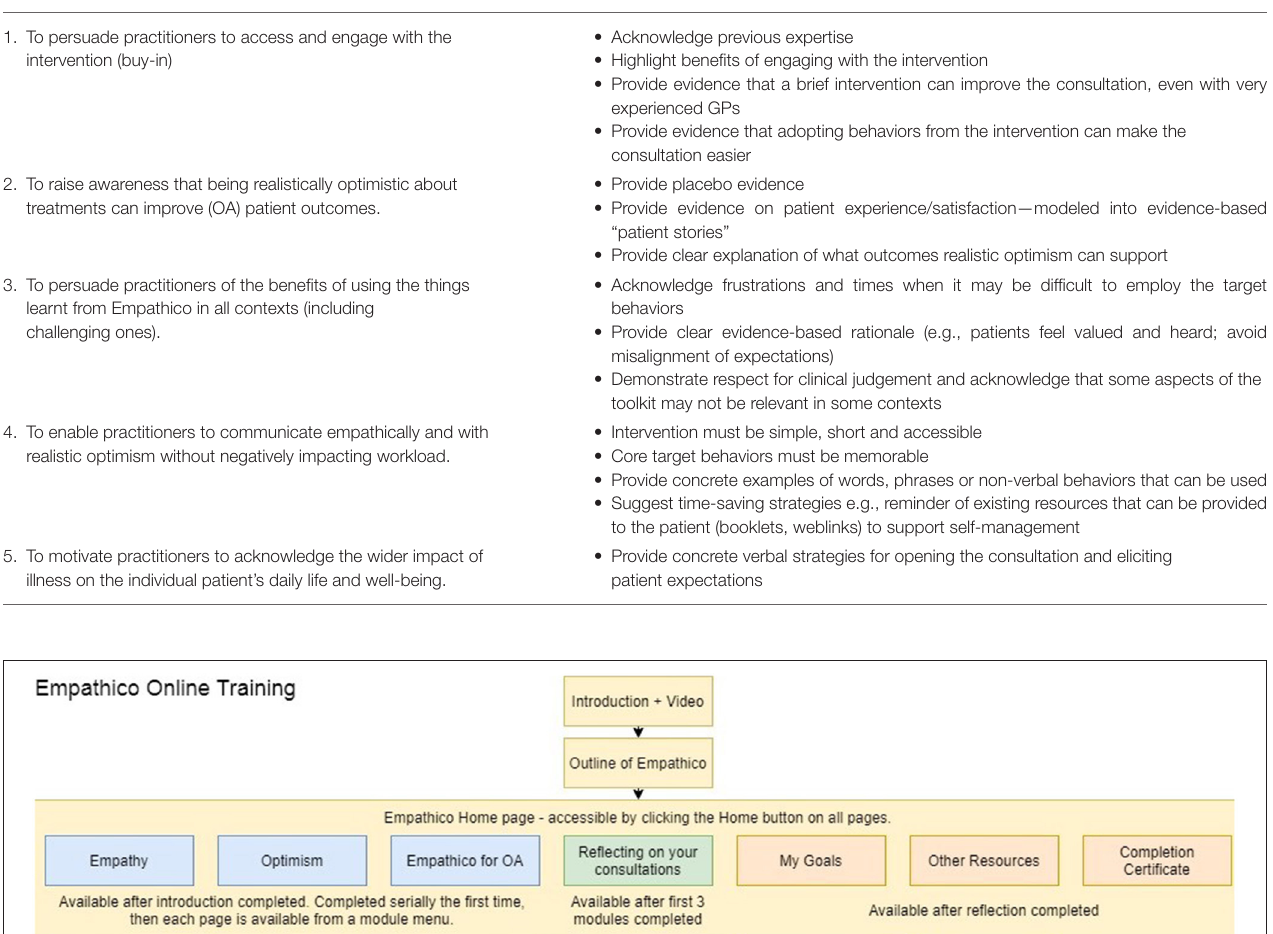
TABLE 5 | Empathico guiding principles. Design objectives